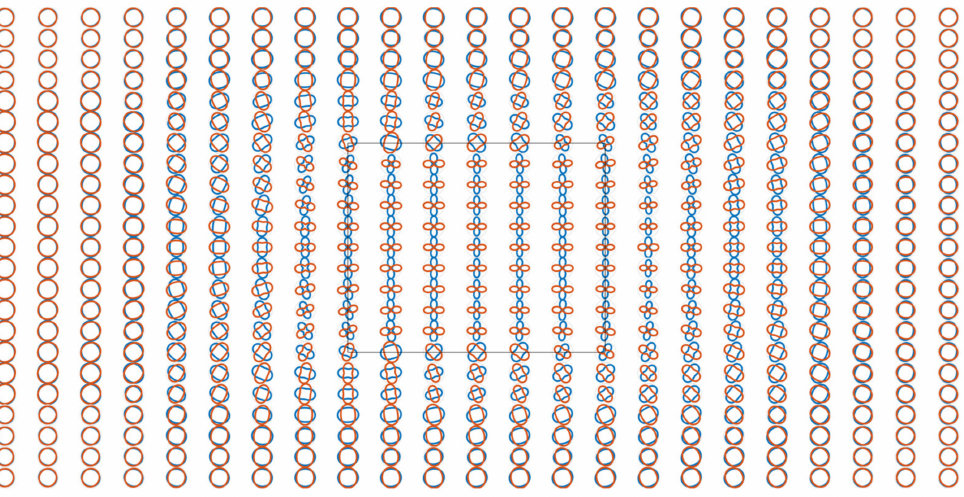
Figure 10. Polar plots of modified COMMEMI 3D-1A model for a frequency of 0.57 Hz. Principal conductivity rotation around the x -axis by 30 ◦